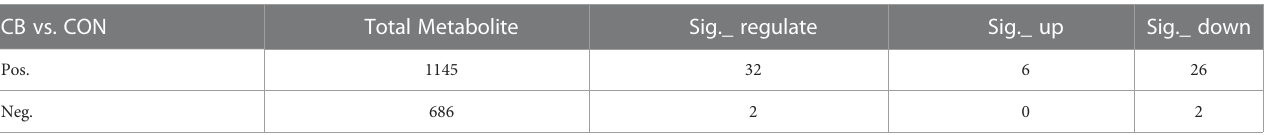
TABLE 3 Metabolite difference screening